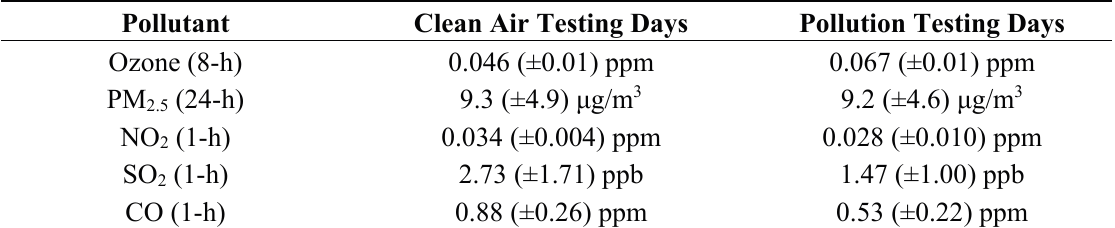
Figure 1. Daily peak 8-h ozone in Salt Lake Valley, UT during Summer 2012. Dashed lines indicate the level of 8-h ozone designated as “Red Alert” and “Yellow Action” days by the Utah Division of Air Quality. “Red Alert” days are defined by an 8 h ozone level >0.075 ppm, which is the value which exceeds the National Ambient Air Quality Standards (NAAQS). “Yellow Action” days are defined by an 8 h ozone level ≥ 0.068 ppm. Poor air quality testing days included those with 8 h ozone level >0.075 ppm, or 2 consecutive or 3 out of 4 days of 8 h ozone ≥ 0.068 ppm. Table 4. Pollutant levels on clean air and pollution testing